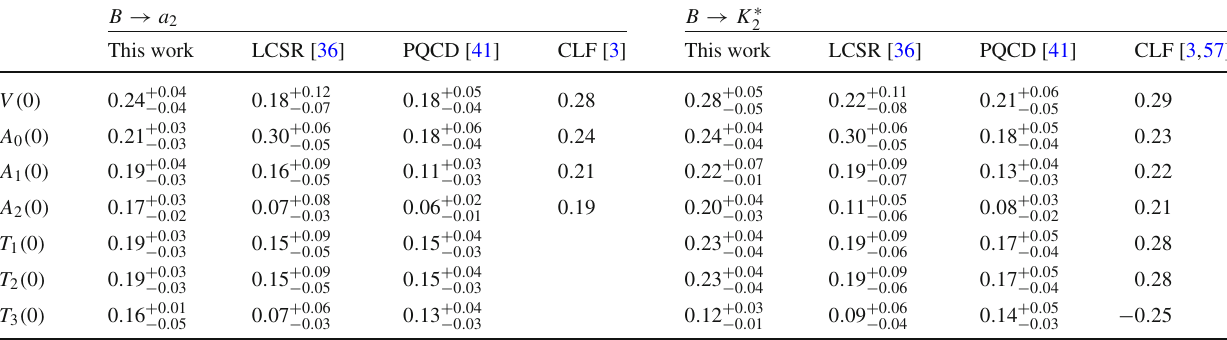
Table 7 Theoretical predictions for the form factors of B → a 2 and B → K ∗ traditional CLF QM [3,57] B → a 2 B → K ∗